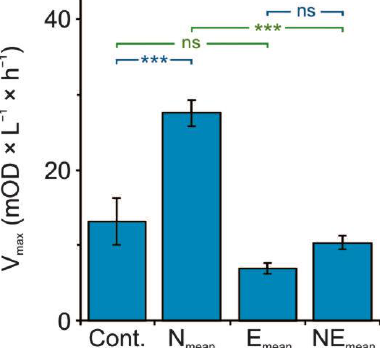
Figure 4. Mean values (± 1 SE) of respiration rate expressed as V max values of 31 carbon sources by Daphnia gut microbiota from the control variant (Cont.) and from variants of a single or combined mean density of polystyrene NPs (N mean for the combined data from N l = 10 3 , Nm = 10 6 , and N h = 10 9 particles L − 1 ) and the mean concentration of enrofloxacin (E mean for the combined data from E l = 10 and E h = 100 ng L − 1 ). Statistical significance is accepted at *** p < 0.0005, ns stands for non-significant. The NPs effect is marked on blue, and the enrofloxacin effect on green.